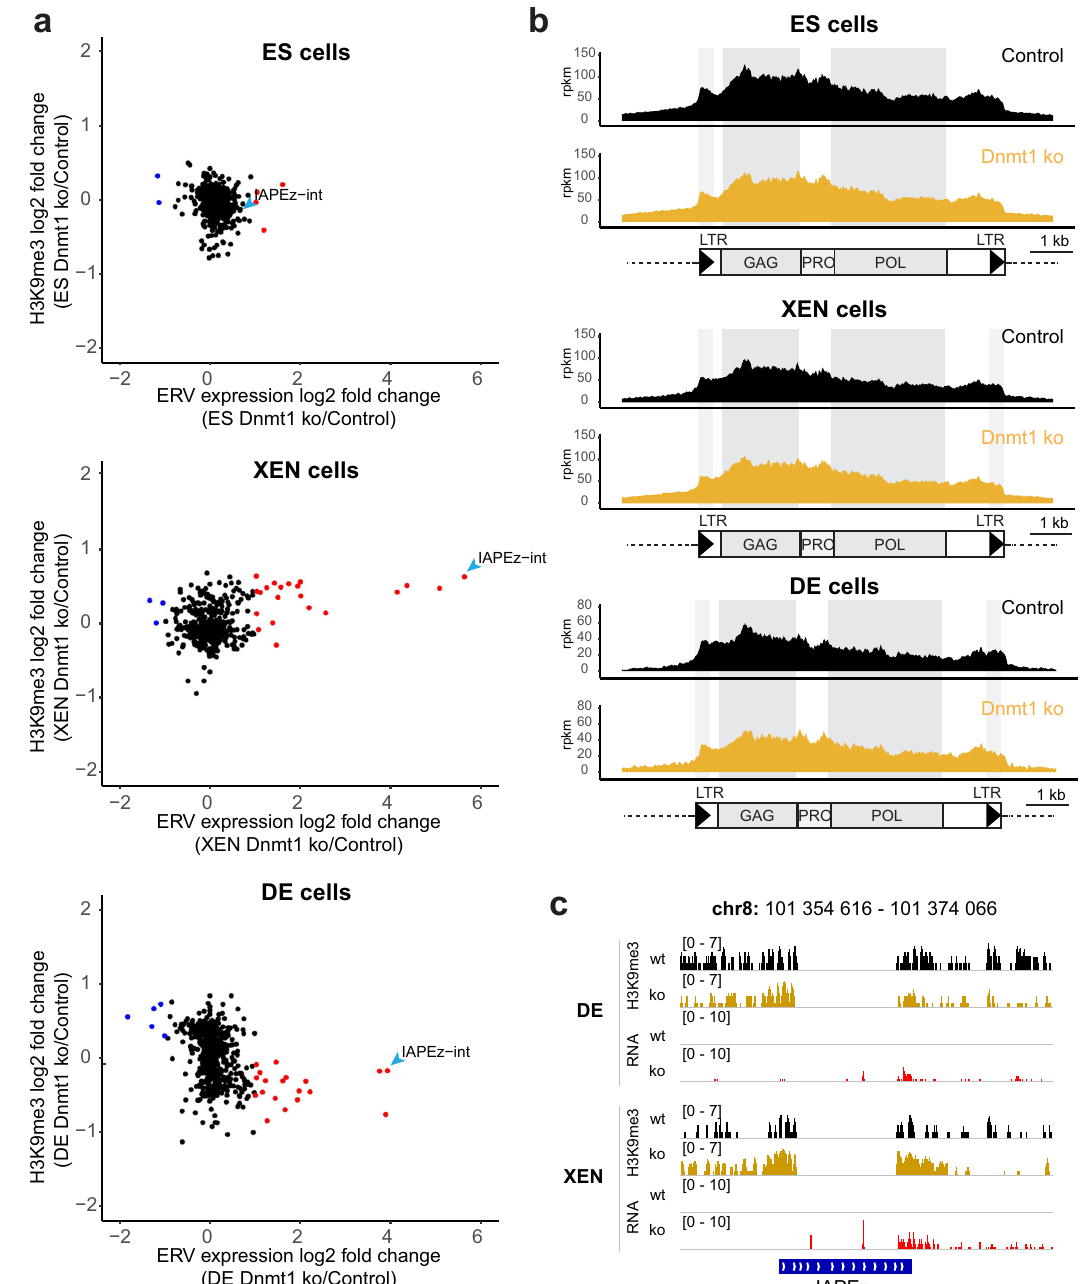
Fig.5|LossofDnmt1leadstoIAPde-repressioninbothXENandDEcells,while H3K9me3ismaintained.a Dotplotshowingbasemeanexpressionvs.H3K9me3 changes of ERV families in ESCs and in vitro differentiated wild type (J1) vs. Dnmt1 ko XEN and DE cells. ERV families with signi fi cantly changed expression (Wald test with Benjamini – Hochberg correction, adjusted p value < 0.01, fold change >2; n =2 for each condition) are colored (red=increased expression in Dnmt1 ko cells, blue = reduced expression in Dnmt1 ko cells). Selected ERV families are labeled. b Cumulative H3K9me3 ChIP-seq coverage across IAP ele- ments in control and Dnmt1 ko ES, XEN and DE cells. The structure of IAP